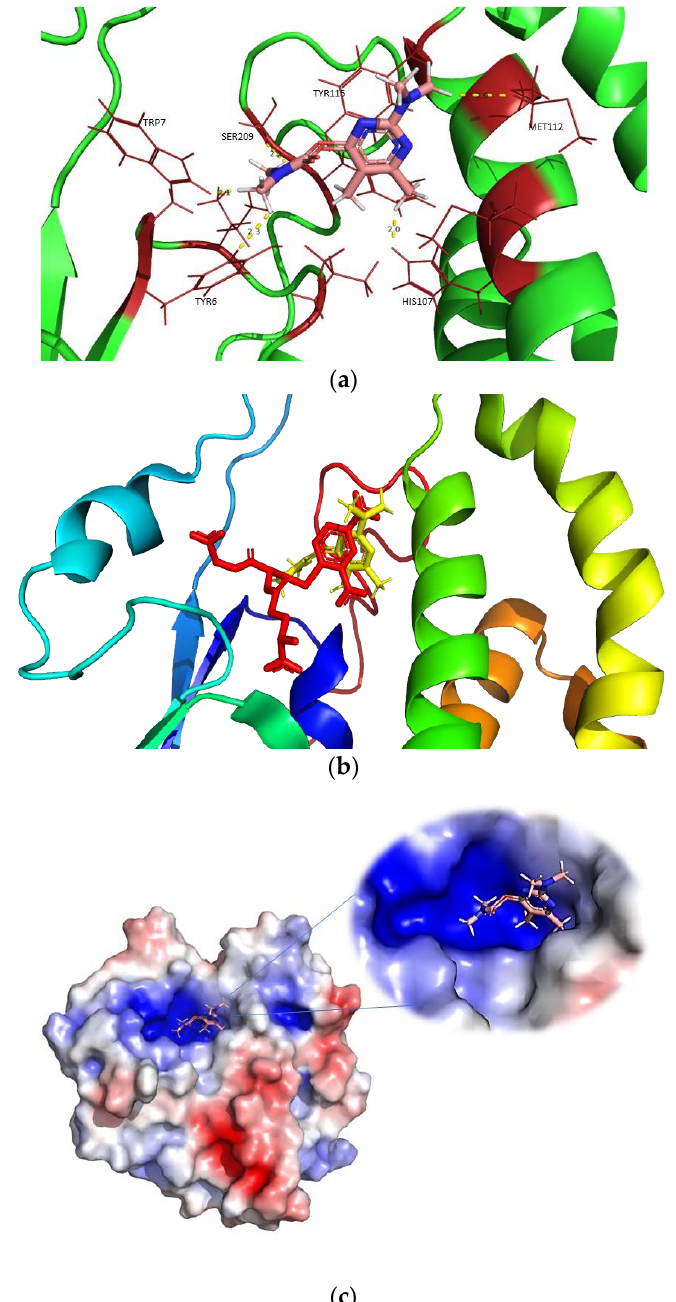
Figure 6. ( a ): The predicted mode of interaction of hGSTM1-1 with the insecticide pirimicarb. Side chains of residues in contact with the ligand (cut-off distance 3.0 Å ) are shown with yellow lines. ( b ): Superposition of pirimicarb (yellow color) with the GSH and CDNB conjugate (GSH-CDNB, red color). ( c ): Electrostatic potential surface around pirimicarb. Red, blue, and white show negative ( − 5), positive (+5) and neutral (0.0) charges, respectively.